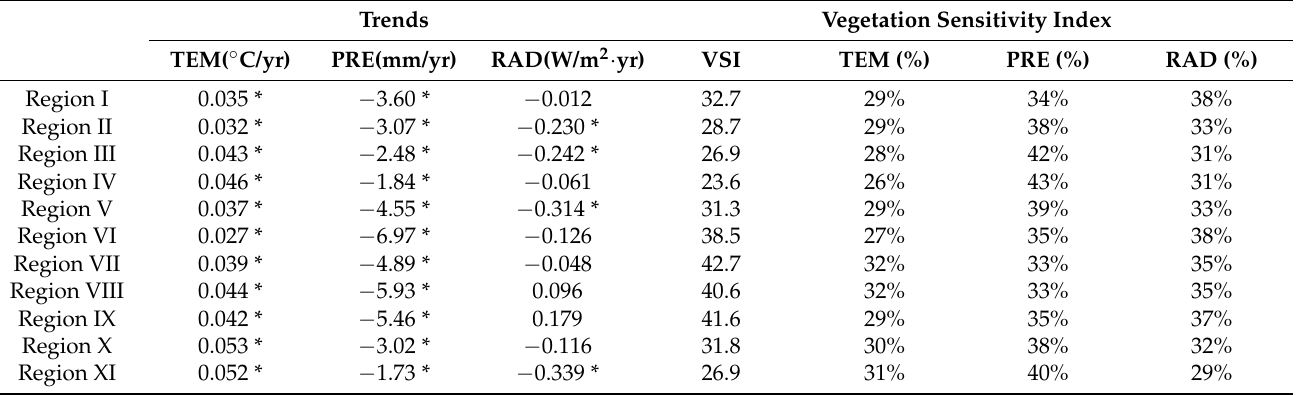
Figure 9. Spatial distributions of contributions of climate variables to VSI: ( a ) TEM, ( b ) PRE, ( c ) RAD, and ( d ) the primary controlling climate variable of VSI. Table 4. Trends of climate variables, Vegetation Sensitivity Index, and climate variable contributions in each sub-region during